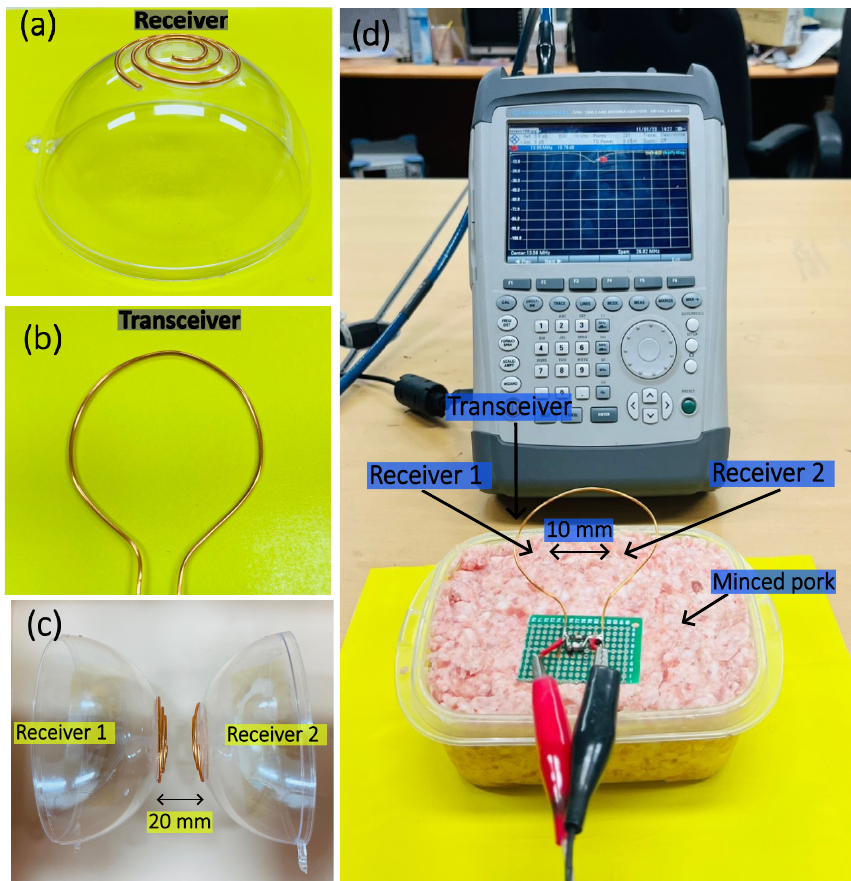
Figure 7. ( a ) The spherical receivers, Rx 1 and Rx 2 , with diameters of 34 mm; ( b ) Planar Tx with a diameter of 61 mm; ( c ) Rx 1 and Rx 2 placed in the air medium with D 12 at 20 mm; ( d ) the experimental setup for measuring S 33 under different